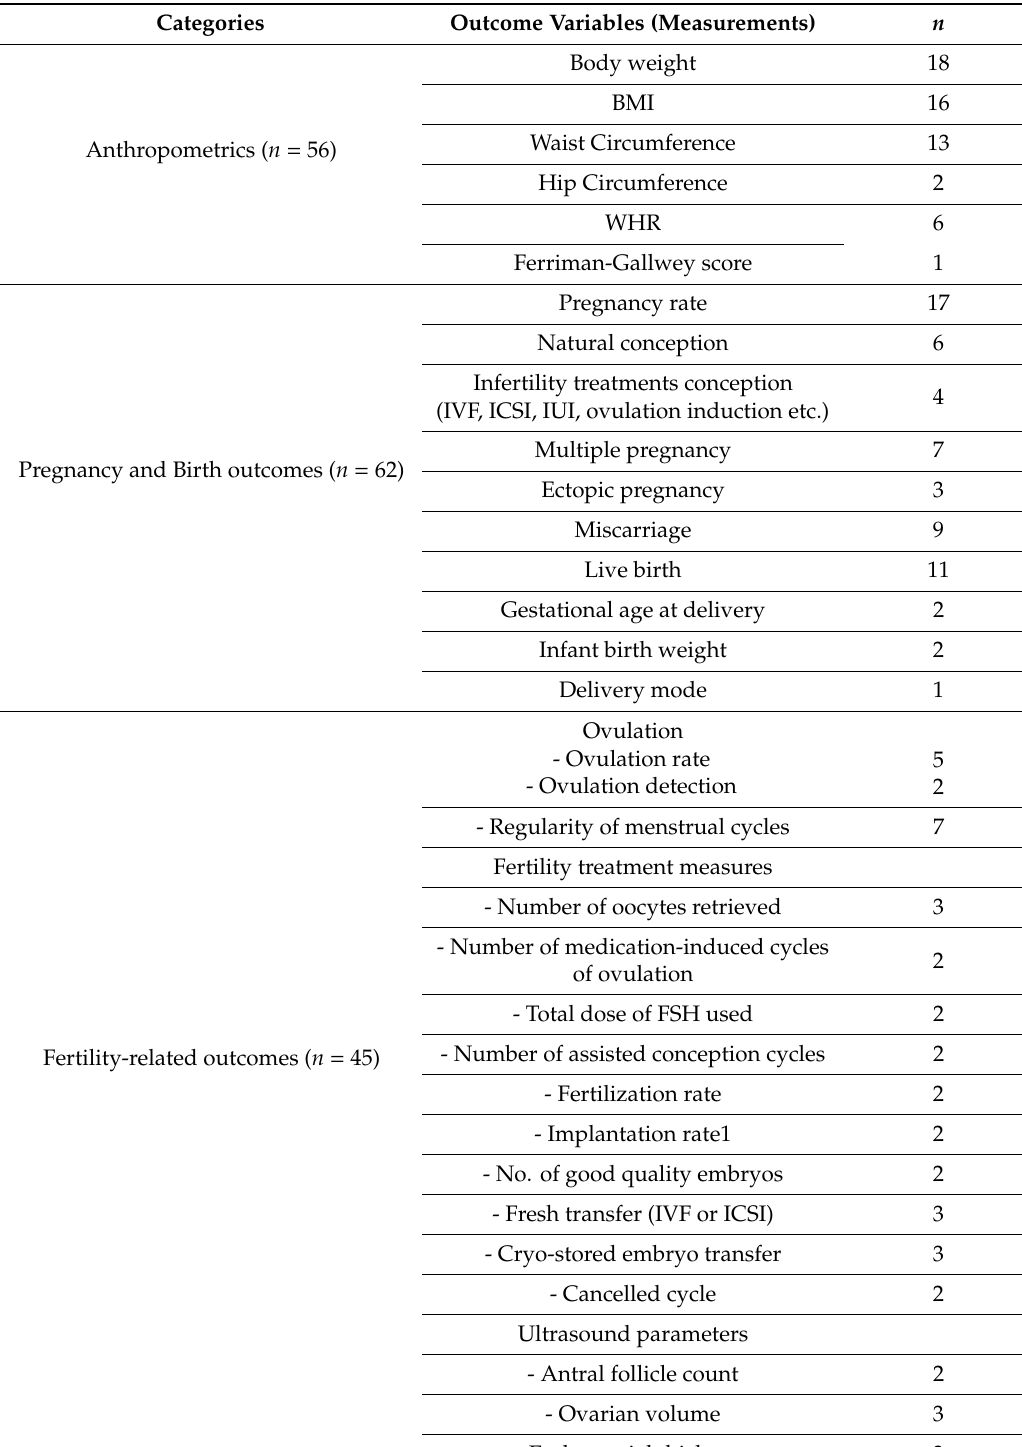
Table 3. Characteristics of the outcome